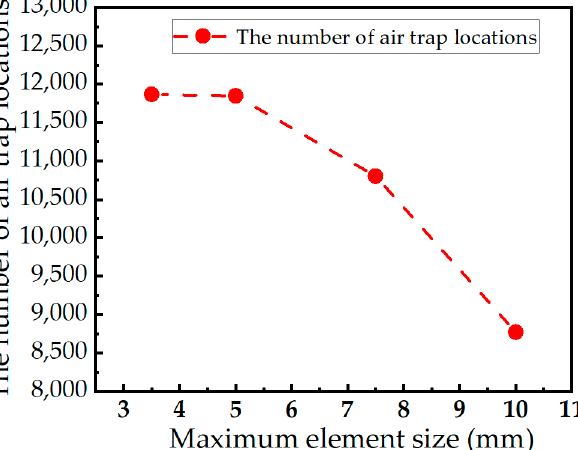
Figure 4. Variation in the number of air trap locations as a function of maximum element size.